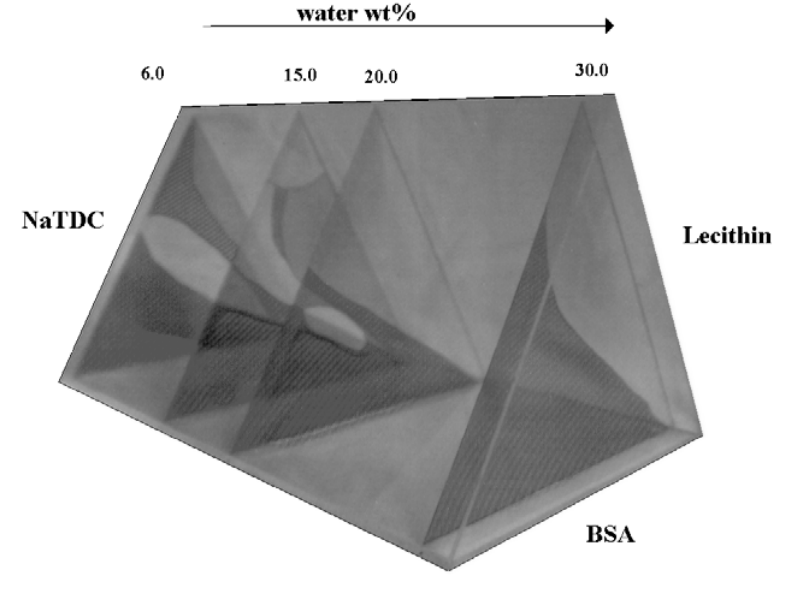
Figure 13. Simplified phase diagram of the system water, NaTDC , C (free from lower and unsaturated homologues) and BSA , at 25.0 °C. For practical purposes, the figure was drawn as a trigonal structure, with the water axis normal to the ternary phase diagrams. Solutions (in dark grey), two-phase regions (middle grey), solutions + gel (pale), solutions plus liquid crystalline dispersions (light grey), solutions + precipitate (middle dark grey) are indicated. The gel phase extending along the BSA rich side is moderate in size. It shrinks with lecithin content and has been